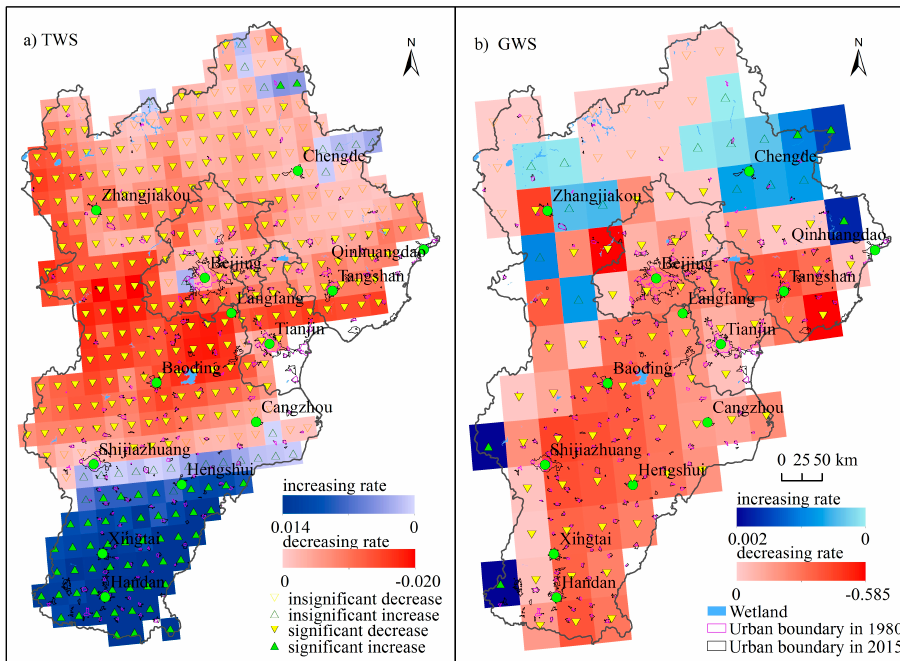
Figure 4. Spatial patterns of changes in TWS and GWS in the Jing-Jin-Ji region estimated by TS and MK methods, respectively, with statistical significance at the 5% level. ( a ) monthly trends in TWS from 1979 to the 2010s; ( b ) monthly trends in GWS from 1979 to the 2010s.